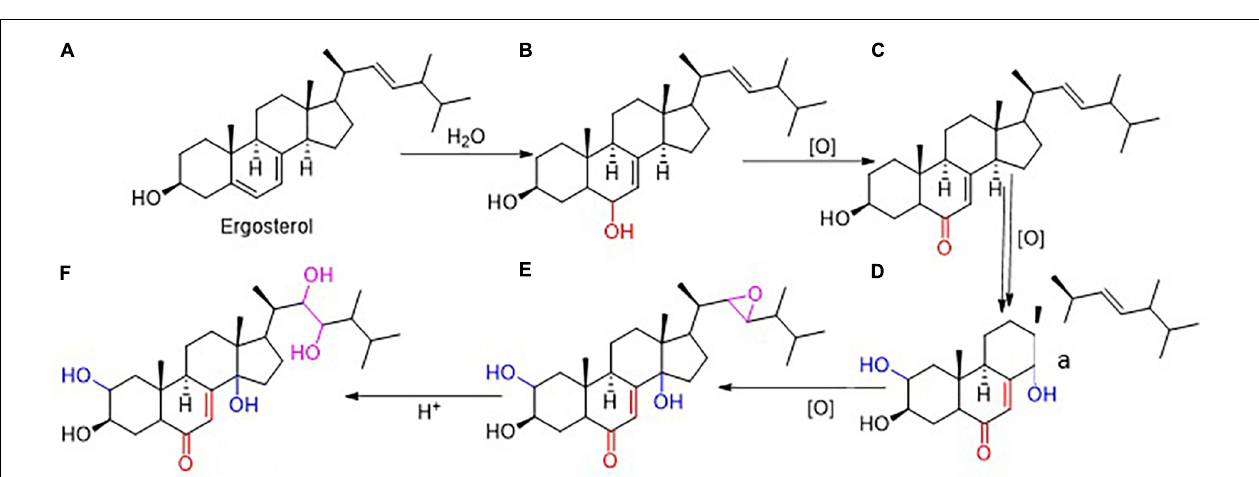
FIGURE 5 | Prediction of Steroids in P. umbellatus transformation. Based on the chemical reactions and series of oxidized reactions, it was deduced that Ergosterol (A) gradually could be converted into Polyporusterone A (F) . During the transition process, (B–E) respectively represented 3,6-dihydroxyergosta-7,22-diene, 3-hydroxyergosta-7,22-diene-6-one, 2,3,14-trihydroxyergosta-7,22-diene-6-one and 2,3-dihydroxyergosta-7-en-6-one-22,23-epoxy.